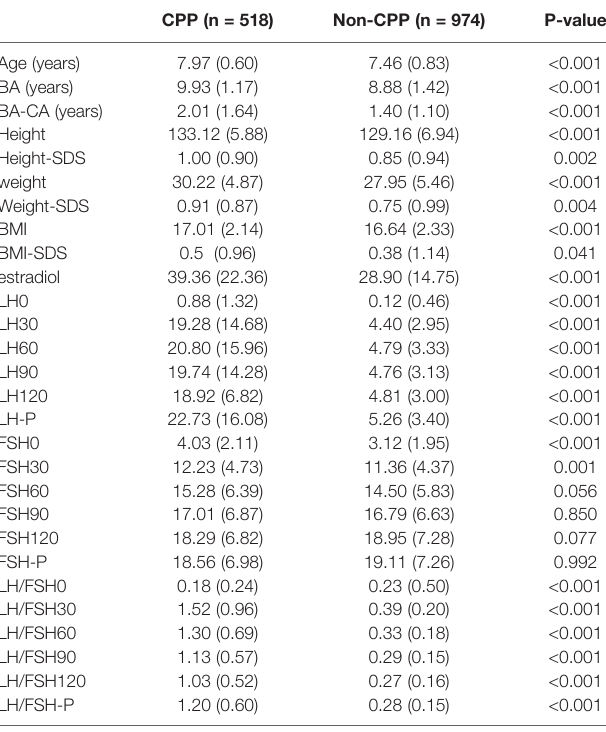
TABLE 1 | Subjects ’ clinical and laboratory